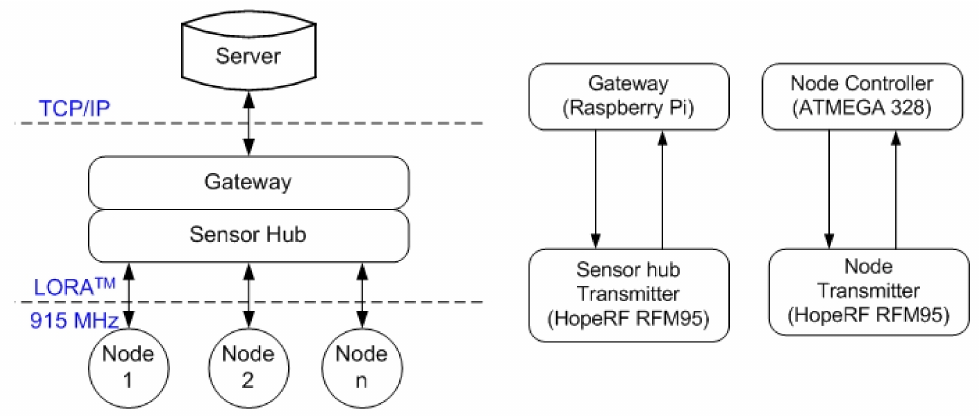
Figure 2. Topology of water level monitoring